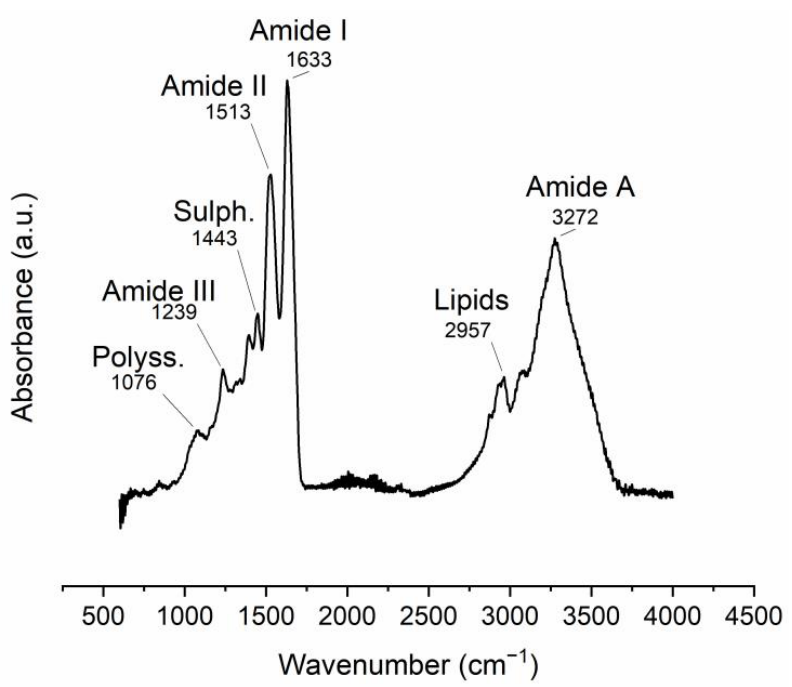
Figure 5. ATR-FTIR spectra of manually obtained ESM. Band position assignments are described in Table 3. Table 3. FTIR vibrational bands observed in the ESM (m: medium, s: strong, v: very, w: weak), table based on [58,60,63,70,96,113 – 115].